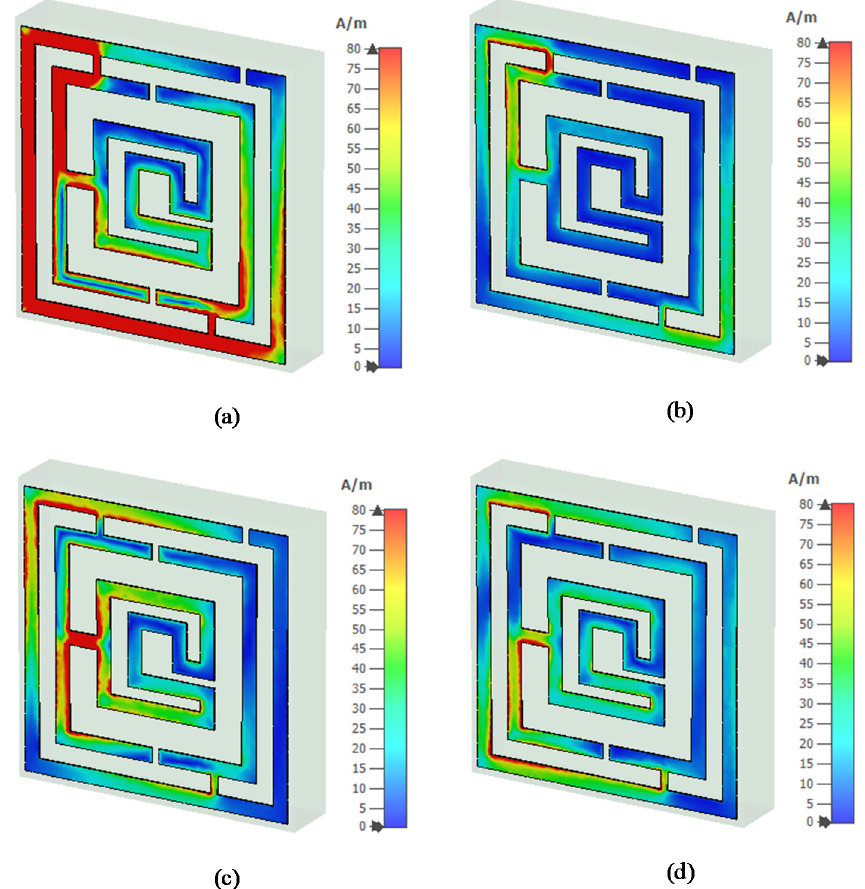
Figure 9. Magnetic field distribution at ( a ) 2.4 GHz; ( b ) 5.6 GHz; ( c ) 8.9 GHz; ( d ) 11.5 GHz.